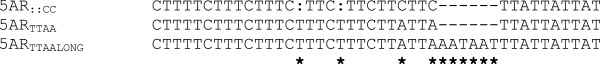
Analysis of the 5′UTR region of AR. Alignment of three haplotypes identified in the 5′UTR of the AR gene in the Brahman bull population. * highlights sites of variation across haplotypes.